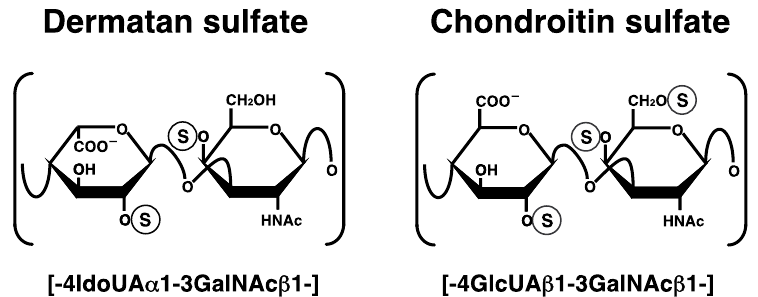
Figure 1. Typical repeating disaccharide units in dermatan sulfate (DS) and chondroitin sulfate (CS), and their potential sulfation sites. The DS backbone consists of L -iduronic acid (IdoUA) and N -acetyl- D -galactosamine (GalNAc), whereas CS is a stereoisomer of DS that includes D -glucuronic acid (GlcUA) instead of IdoUA. These sugar moieties may be esterified by sulfate at various positions indicated by the circled ‘S’.